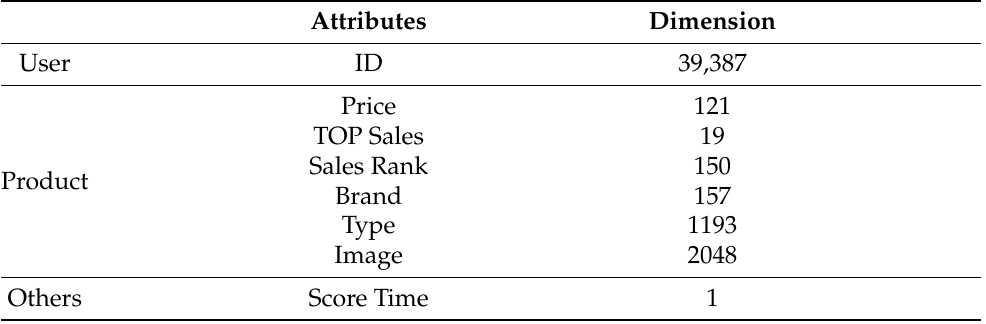
Table 3. The processed attributes of the Amazon